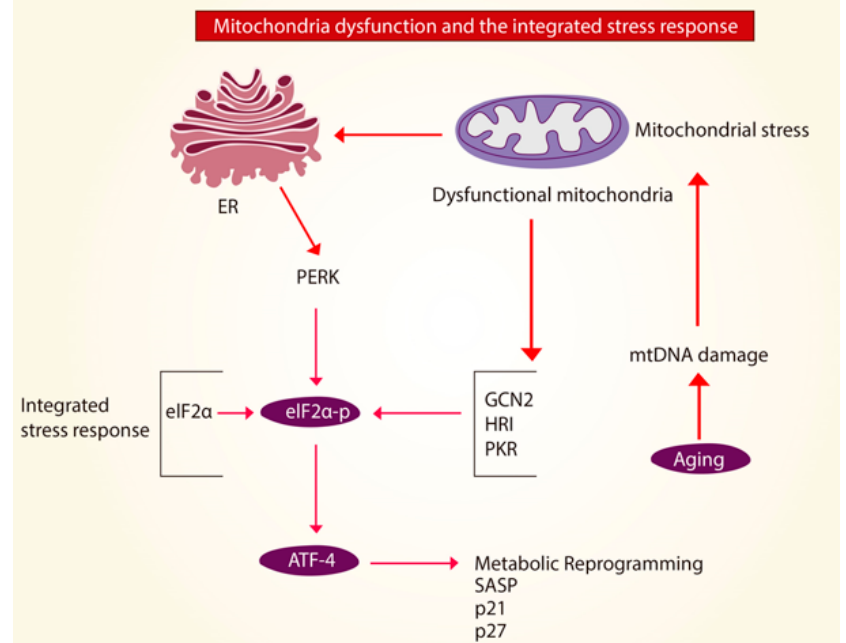
Figure 4. Mitochondria dysfunction and the integrated stress response (ISR). In aging, it is possible that mitochondrial stress and mitochondria dysfunction caused by mitochondria DNA (mtDNA) damage activates the integrated stress response (ISR) leading to phosphorylation of the eukaryotic translation initiation factor 2 subunit 1 (eIF2 α ) by the kinases GCN2, PERK, HRI and PKR. This causes activation of the transcription factor 4 (ATF4) to allow protein recovery and promote cellular homeostasis. Overexpression of ATF4, can modulate the actions of p21, p27, drive the senescence-associated secretory phenotype (SASP) and stimulate a metabolic reprogramming in the cell that could predispose to fibrotic disease.